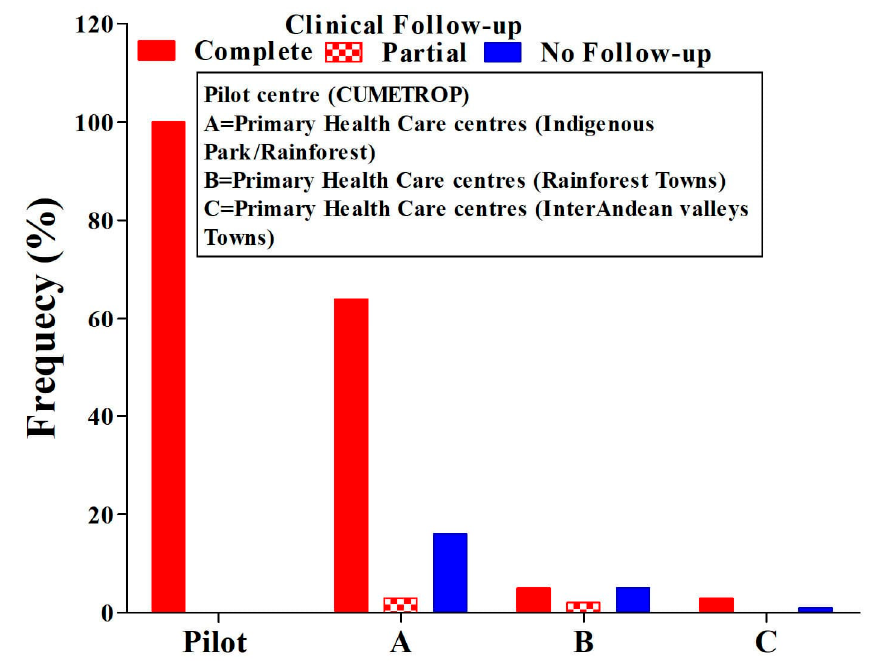
Figure 3. Comparison of ulcer conditions means clinical evaluation in the post-treatment follow-up period. ANOVA test, p = 0.01; CUMETROP = Centro Universitario de Medicina Tropical.